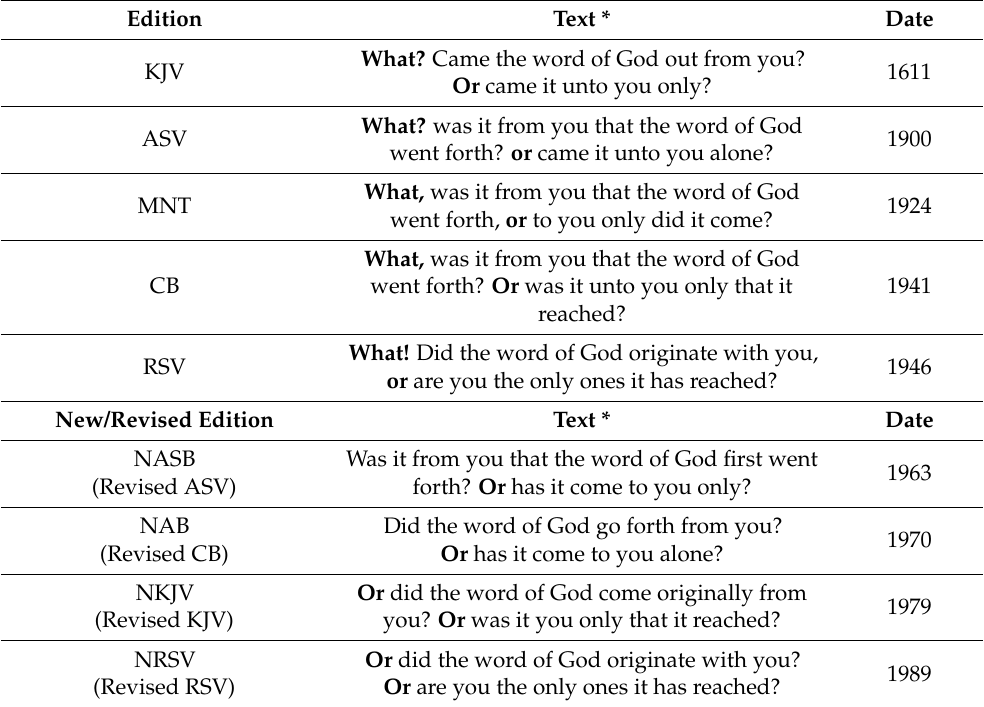
Table 2. Selected English NT translations and revised translations of 1 Corinthians 14:36 *.